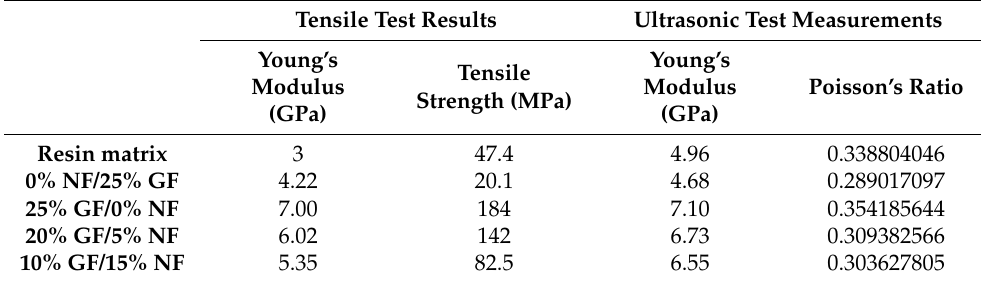
Table 3. Young’s modulus, tensile strength, and Poisson ratio measurements using a destructive (tensile test) and non-destructive technique (ultrasonic